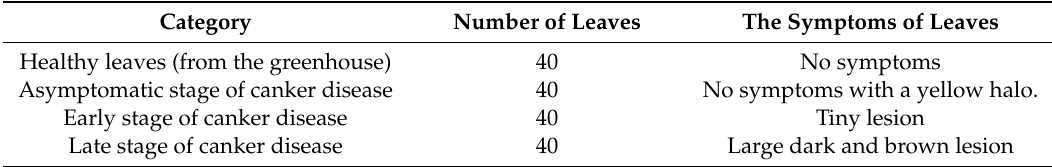
Table 1. Number of leaves collected for each category studied in this work. Category Number of Leaves The Symptoms of Leaves Healthy leaves (from the greenhouse) 40 No symptoms Asymptomatic stage of canker disease 40 No symptoms with a yellow halo. Early stage of canker disease 40 Tiny lesion Late stage of canker disease 40 Large dark and brown